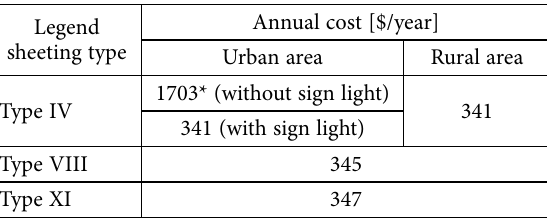
Table 6. Average annual cost of replacing sign sheeting with various legend sheeting types